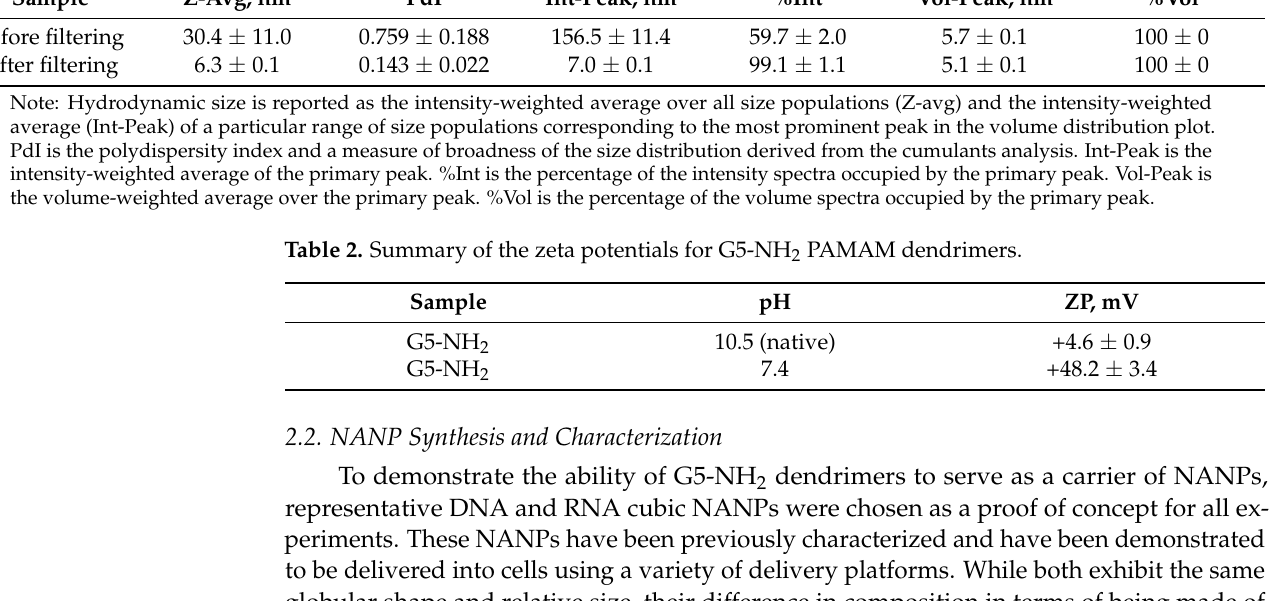
Table 2. Summary of the zeta potentials for G5-NH 2 PAMAM dendrimers.